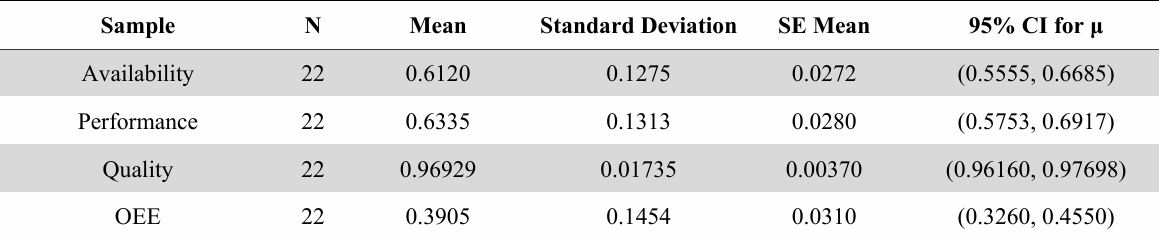
One-Sample t-test